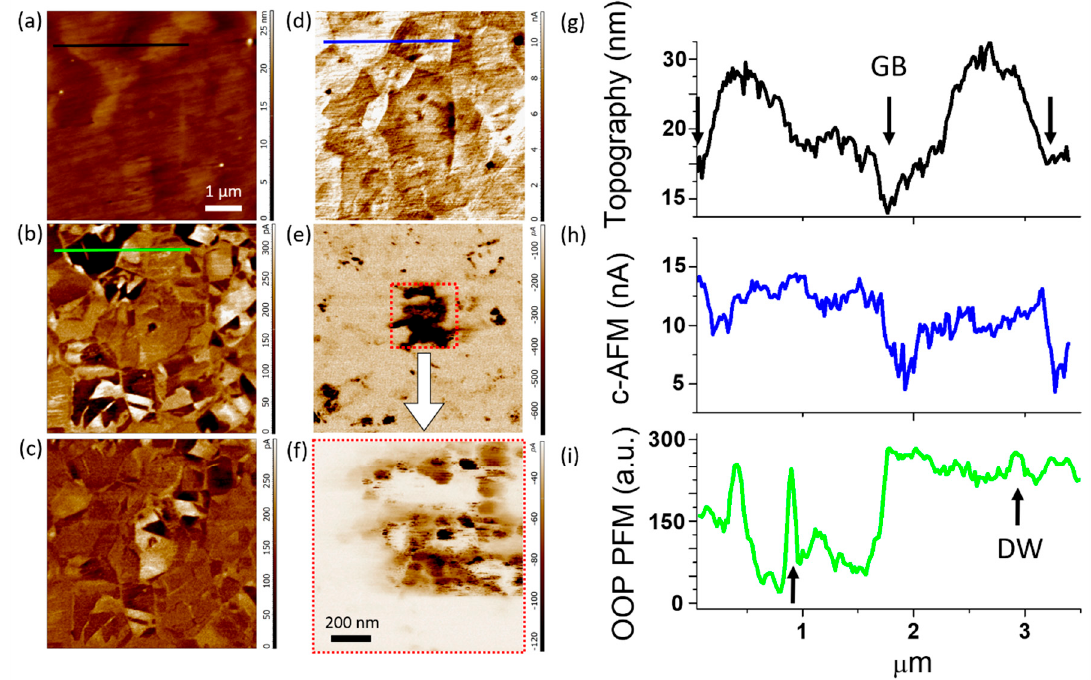
Figure 1. Scanning probe microscopy (SPM) measurements of the Bi 0.95 Ca 0.05 FeO 2.975 sample: ( a ) surface topography, ( b ) out-of-plane (OOP) PFM response, ( c ) in-plane (IP) PFM response, ( d ) c-AFM response at positive DC bias voltage of 5 V, ( e ) c-AFM response at negative DC bias voltage of − 5 V, ( f ) magnified c-AFM image of the area marked by the red dotted square in ( e ). Cross-section profiles for ( g ) topography, ( h ) c-AFM, and ( i ) OOP PFM. The arrows indicate the position of grain boundaries (GB) and domain walls (DW) on the corresponding cross-section profiles.